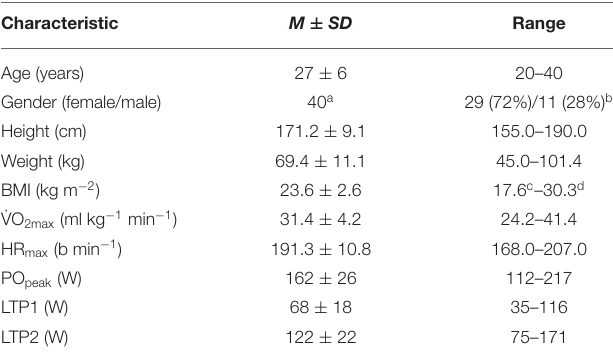
TABLE 1 | Demographic and anthropometric characteristics of participants at baseline ( N = 40